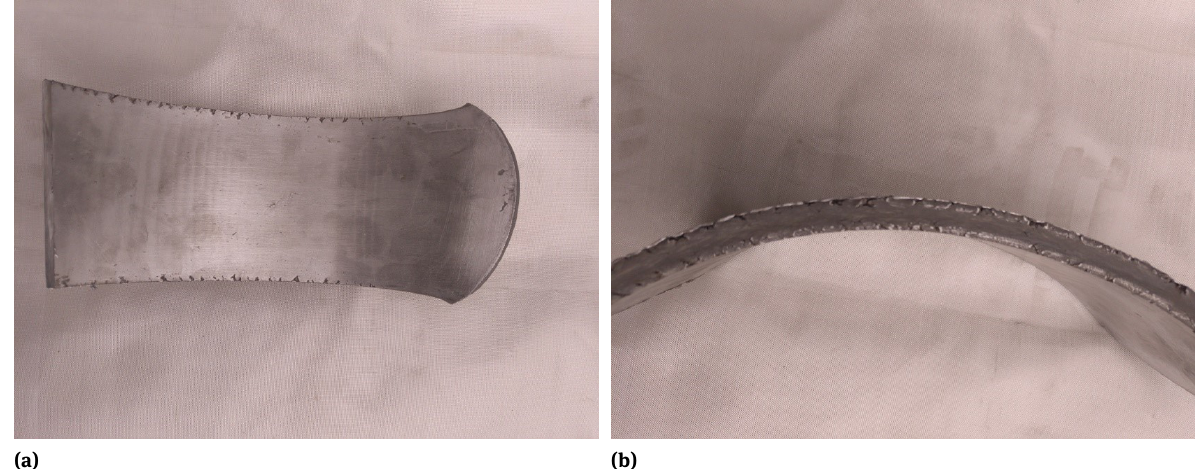
Figure 6: View of the third billet after rolling: a - from above; b - on the side